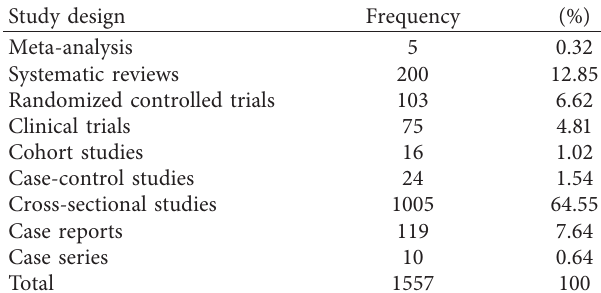
Table 2: Classification of the extracted articles according to the design of the